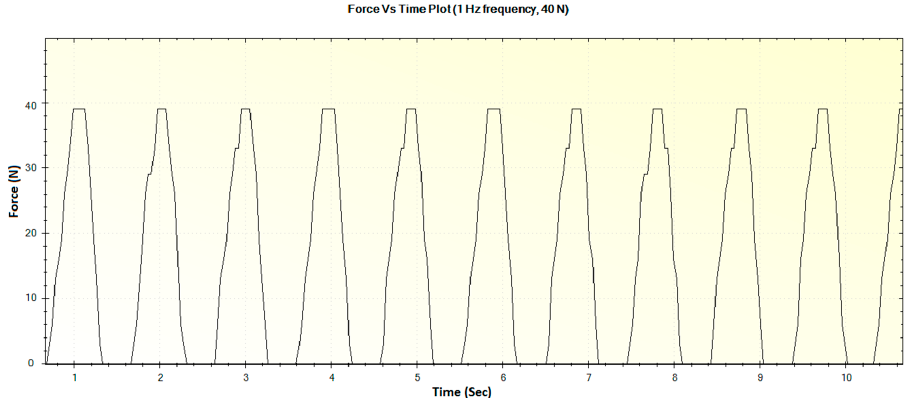
Figure 19. Generated waveform for 1 Hz operation producing a force of 40 N.